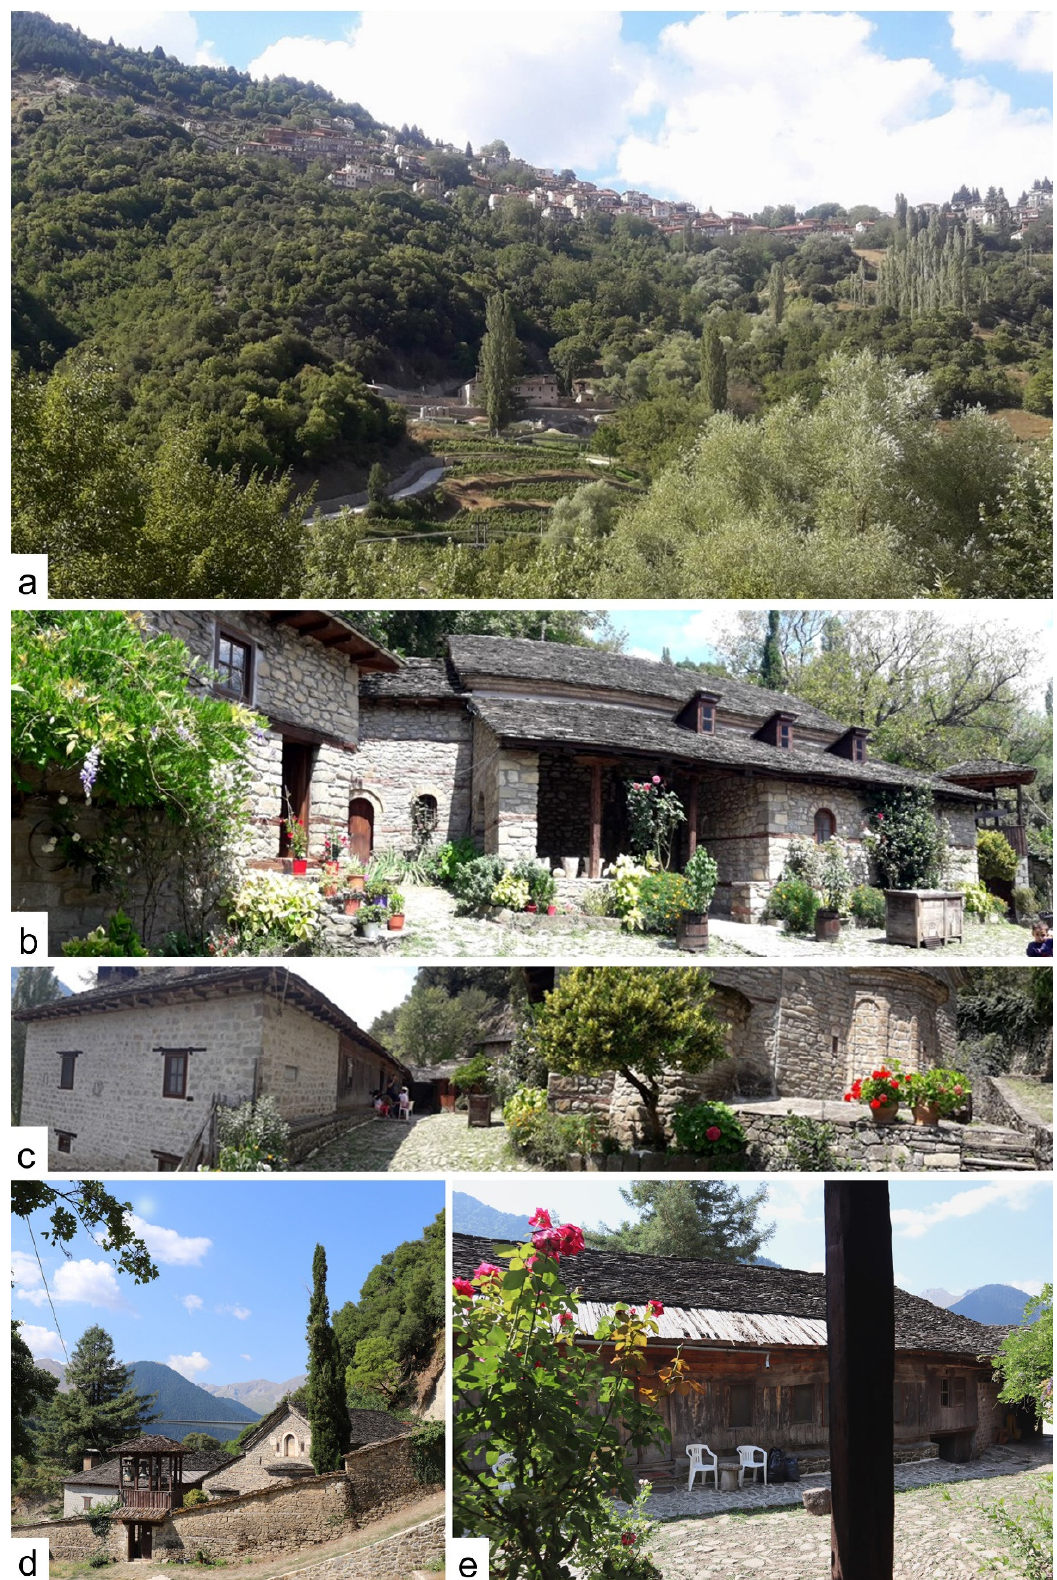
Figure 2. Monastery of St. Nicholas, located SW of Metsovo; ( a ) general position, ( b–d ) views from the Monastery complex, ( e ) Monastery’s auxiliary building from where samples were collected.